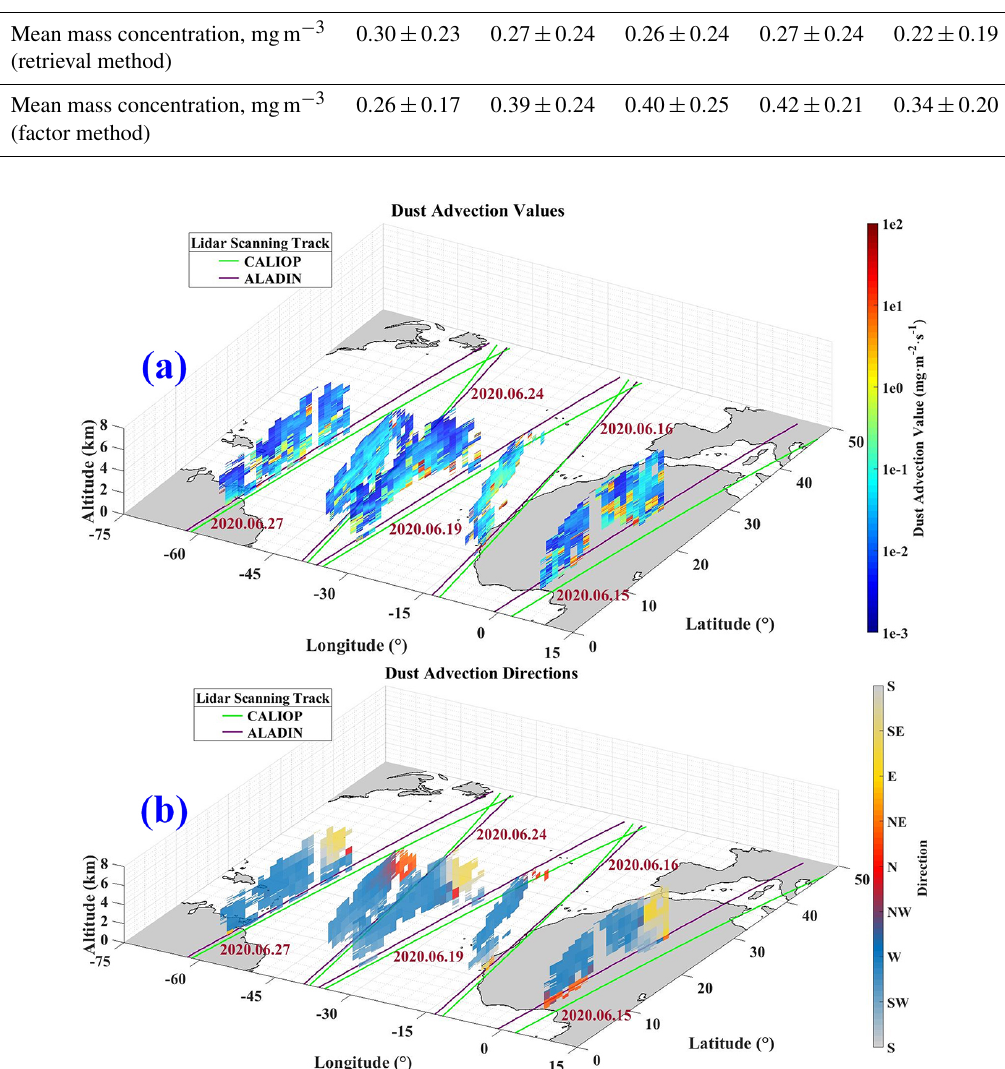
Figure 9. The dust advection calculated with data from ALADIN, CALIOP and ECMWF. (a) Dust advection values at different cross- sections and at different times during the dust transport and (b) dust advection directions at different cross-sections and at different times during the dust